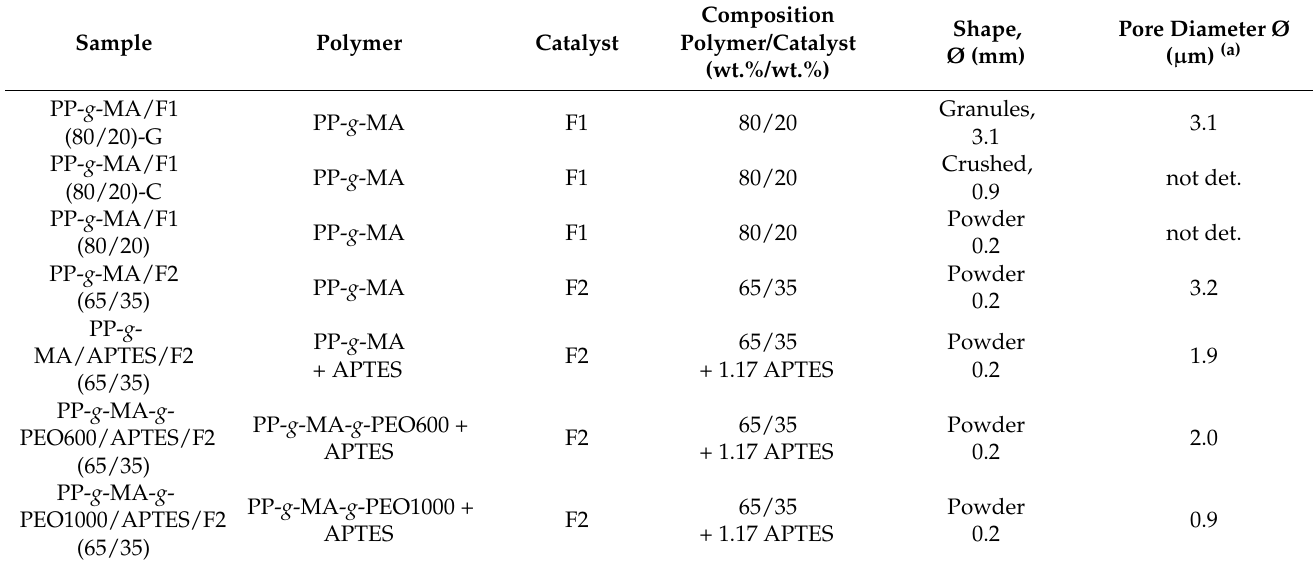
Table 2. Composition and characteristics of the Fenton polymer